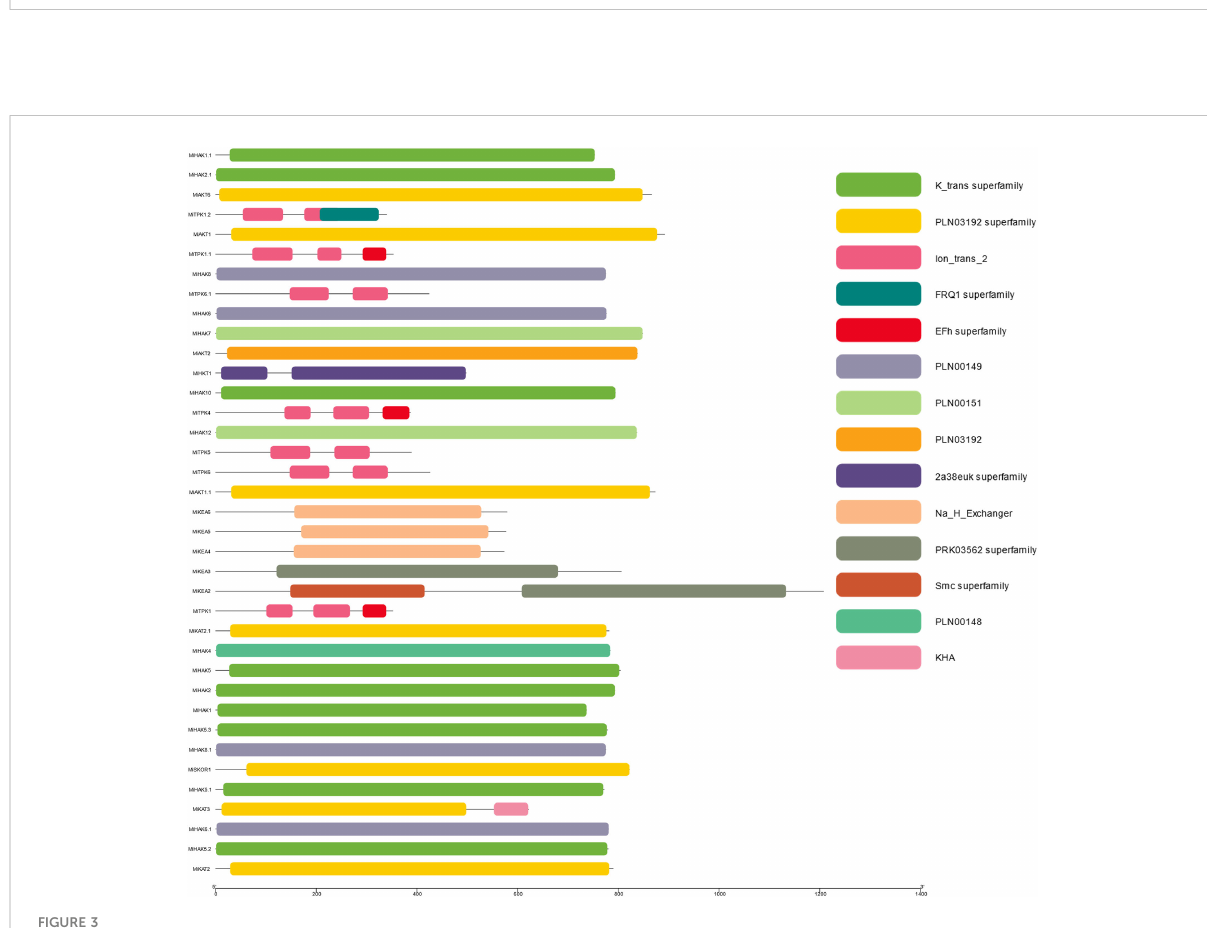
FIGURE 3 Most conserved domain of K + transporting proteins in Mangifera indica